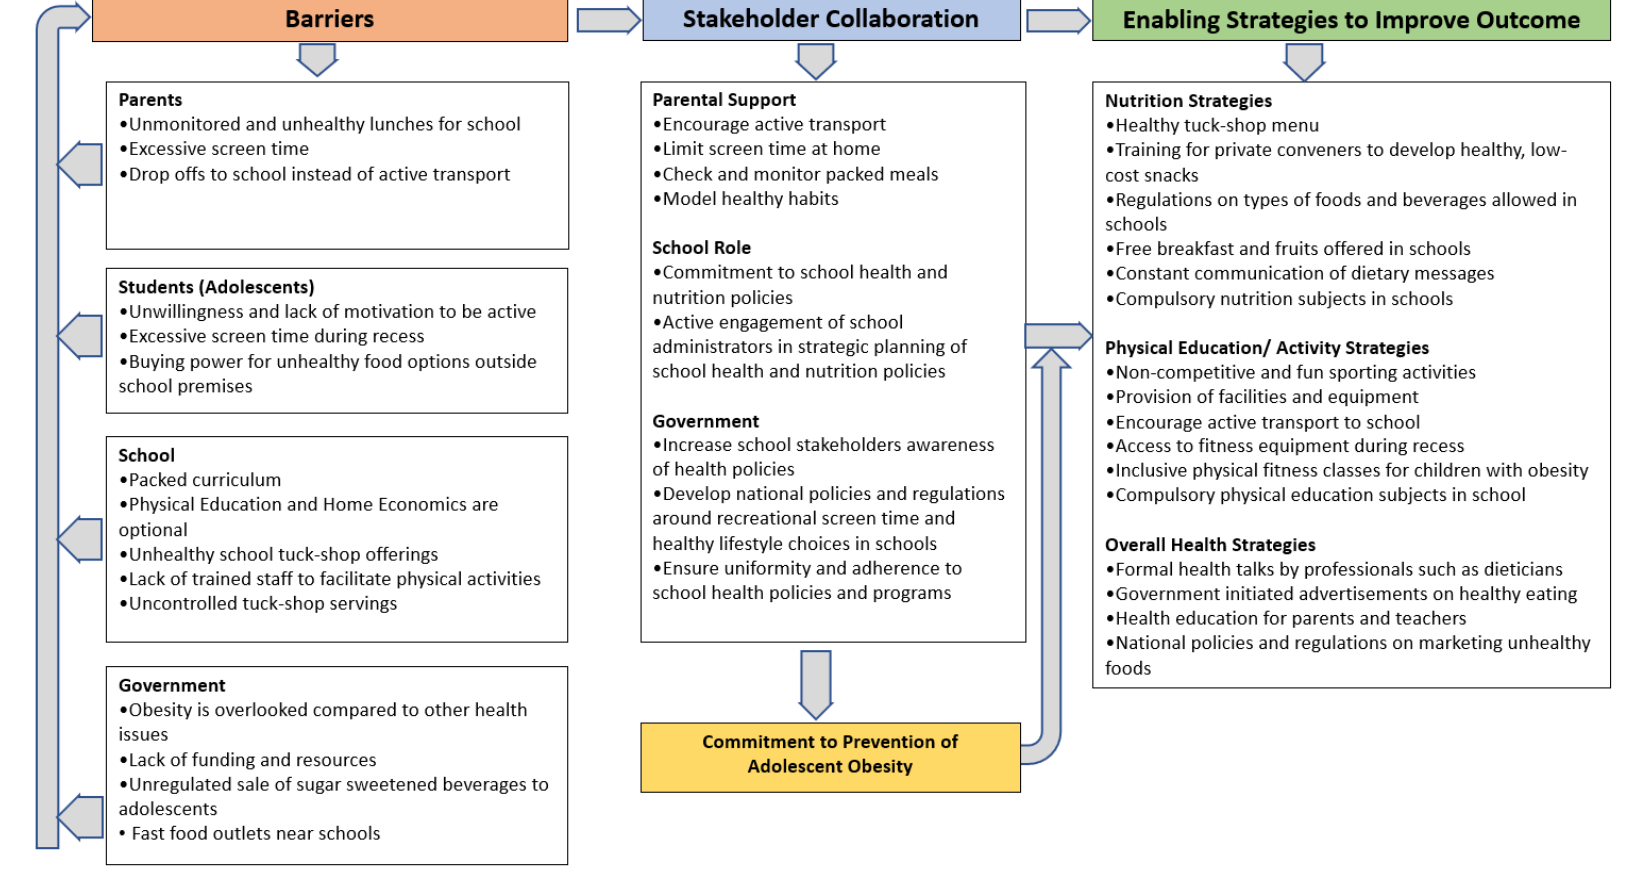
Figure 1. Model for the prevention of adolescent obesity representative of Queensland school stakeholders’ perceptions.